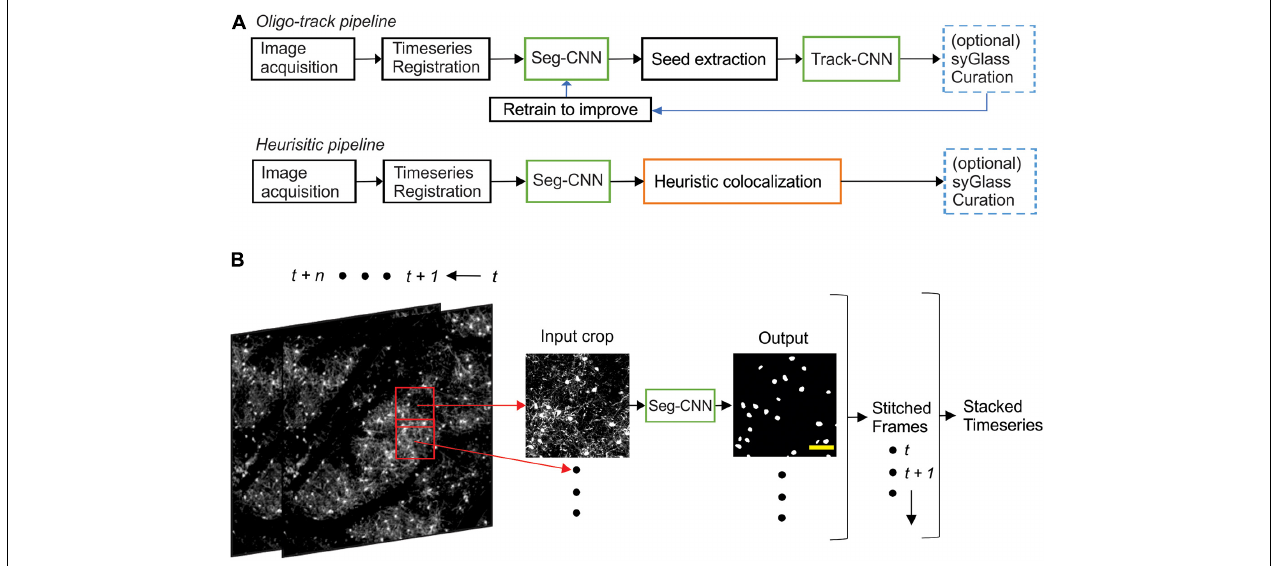
FIGURE 2 | Computational neural network analysis pipeline. (A) Overview of the sequential CNN multi-object tracking pipeline Oligo-Track (top). CNNs marked in green. Overview of heuristic baseline method (orange) for comparison to Oligo-Track (bottom). Compatibility with optional syGlass curation provides validation of tracking in both pipelines (blue). Curated tracks can also be reintroduced into training pipeline for refinement of CNNs. (B) Seg-CNN pre-processing extracts cropped regions from larger volumes with 50% overlap for computational efficiency at each timepoint t to t + n . Cropped regions are restitched to form timeseries. Scale bar: 50 µ